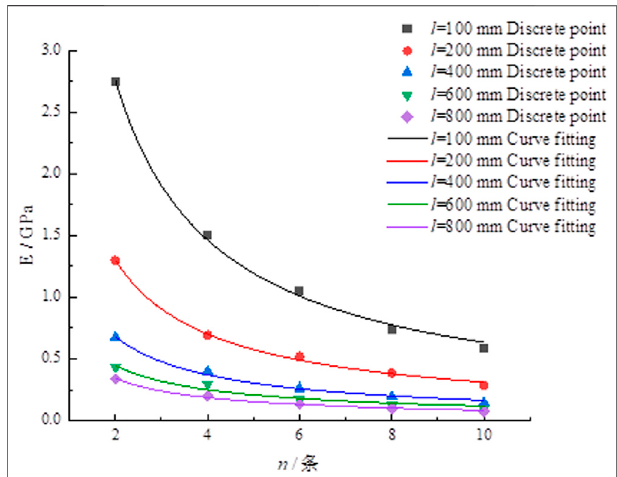
FIGURE 2 | Fitting curves of rock elastic modulus with different number of